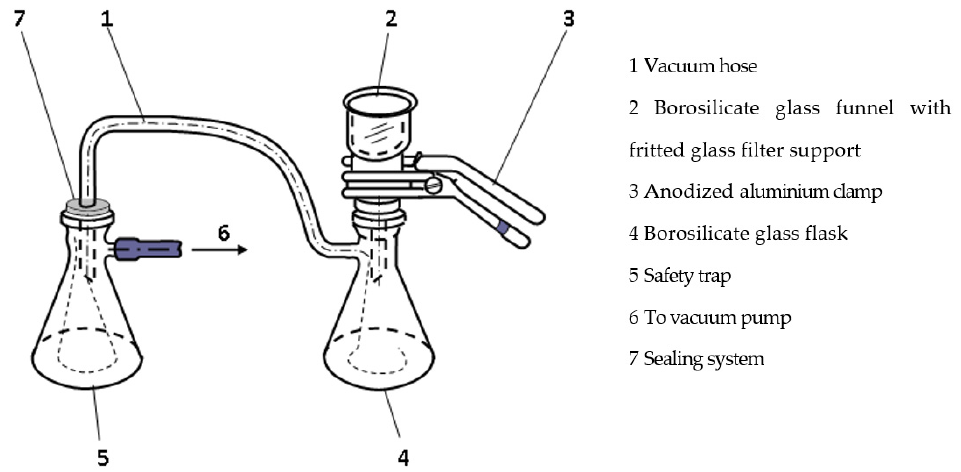
Figure 3. Schematic diagram of the lab-scale filtration system used for beer filtration experiments. To simulate the filtration conditions of beer in industry, a mineral filtration layer (filter cake) was deposited on a filter support, and doses of fine-size material (filtration dosage) mixed with the beer before filtration (to ensure beer clarification) were used. Filter papers (wide pore size) were used on the filter support to maintain the filtration layers. 3 g of filtering materials in different mixture ratios (Table 1) were used to form the filtration layer. Firstly, 50 mL of ultrapure water was mixed with the filtering material and added to the filter in order to remove the very fine particles for the filtering material and form a uniform layer of filter cake. 0.5 g of fine-size filtering aids (kieselguhr or zeolite) were used as filtration dosage to form a slurry with 100 mL of beer (approximately 0.5%